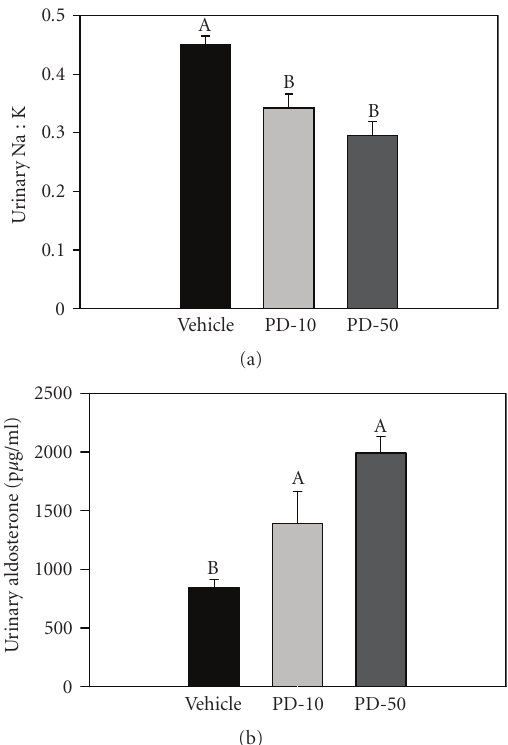
Figure 4: Aldosterone activity and excretion. (a) urinary sodium to potassium ratio (Na:K) and (b) aldosterone excretion in normal male SD rats chronically treated with vehicle (VEH), PD168 at the dose of 10mg/kg · body weight (PD-10) or with PD168 at the dose of 50 mg/kg · body weight (PD-50), ( n = 10/treatment group). Means were compared using one-way ANOVA followed by Holm- Sidak test. Data are represented as means ± SEM. Di ff erent letters represent significant di ff erences between the groups with “A” being highest mean and so forth ( p < 0 . 05 was considered significant).